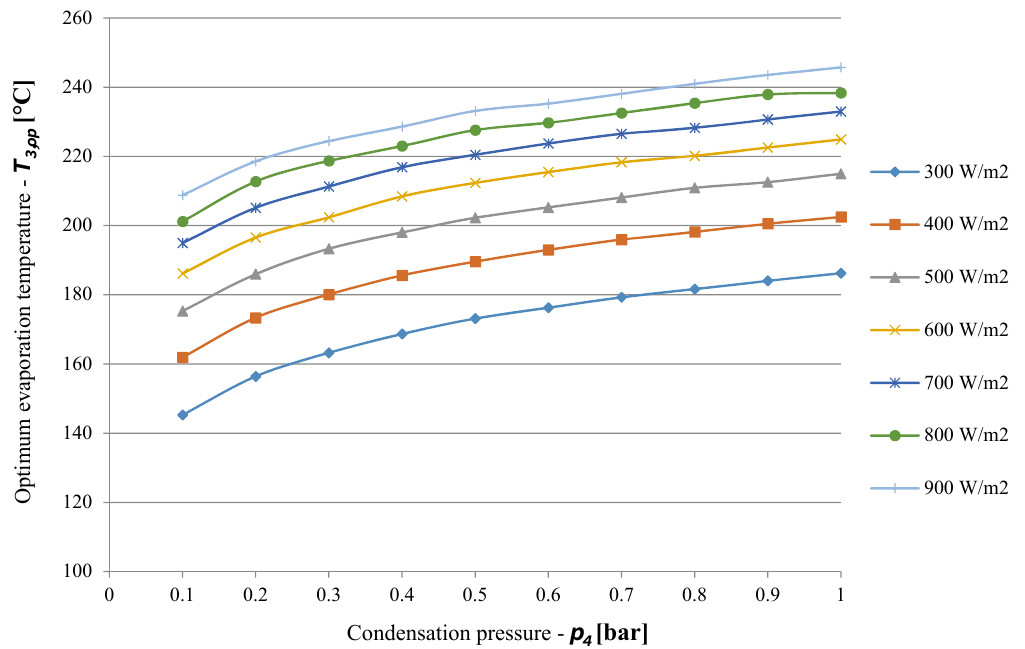
Figure 12. Optimal evaporation temperatures versus solar radiation and condensation pressure.